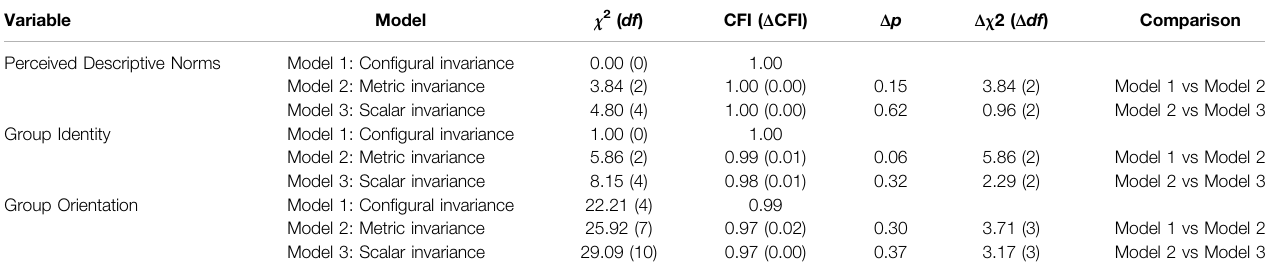
TABLE 3 | Fit Indices for Measurement Invariance Tests between the Herding Group Members vs Village Group Members. Variable Perceived Descriptive